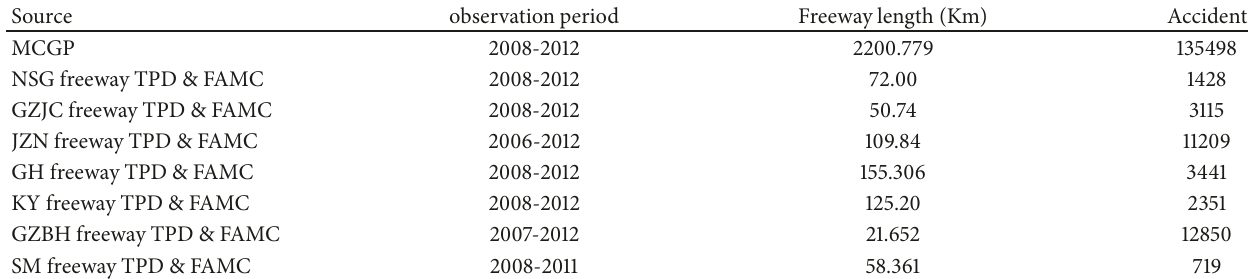
Table 1: Sample source and size.